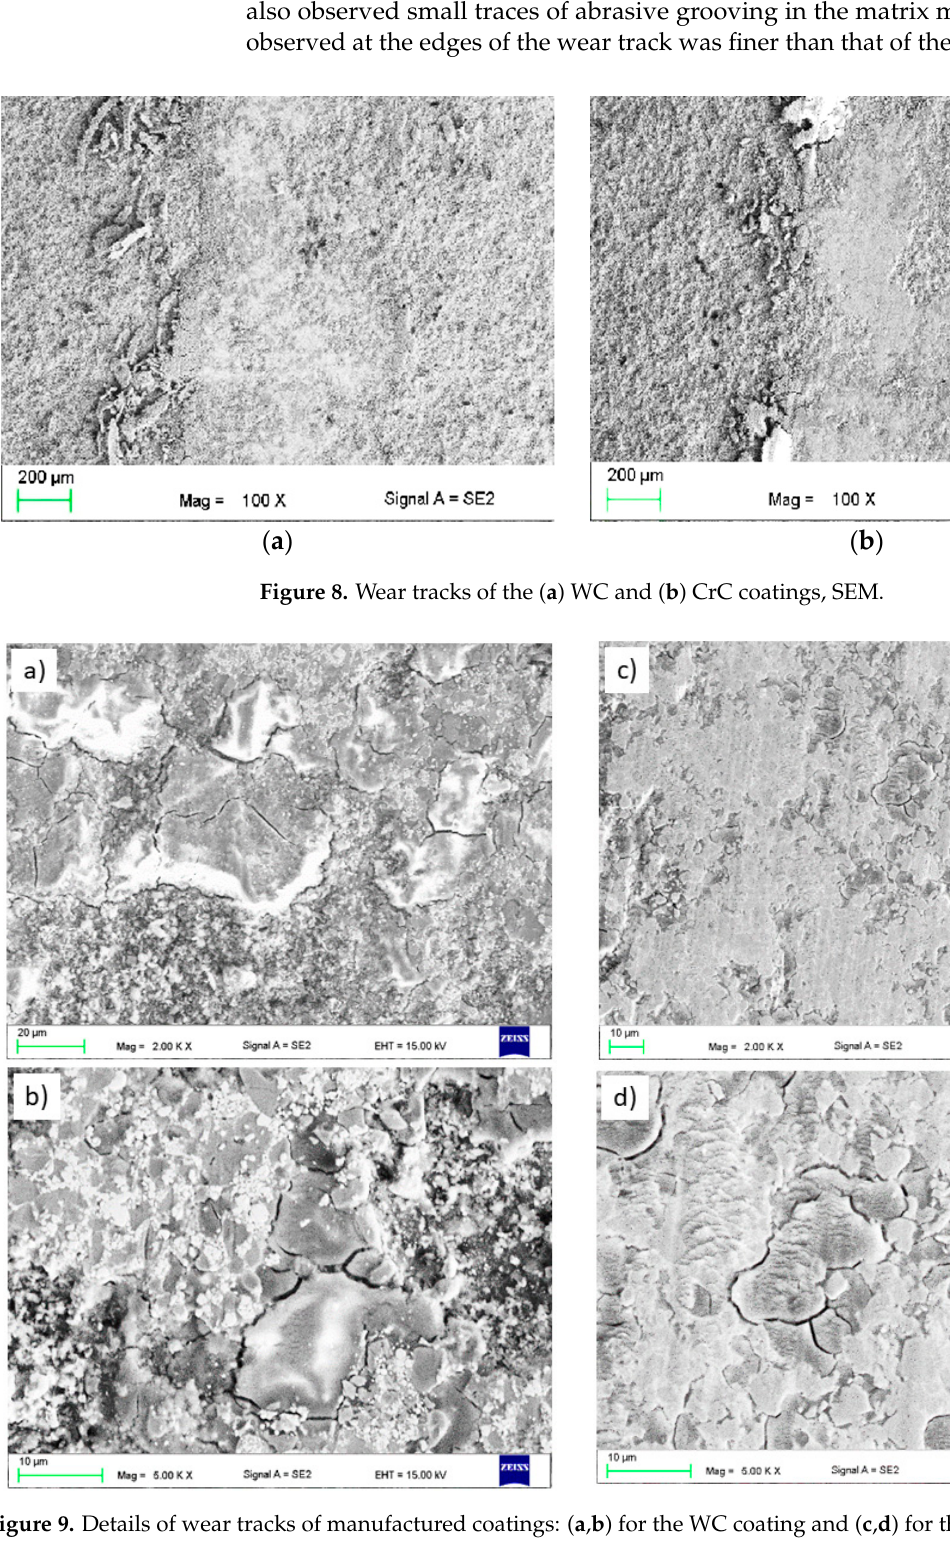
Figure 10. Wear debris observed at the edge of the wear track: ( a ) WC and ( b ) CrC coatings, SEM.